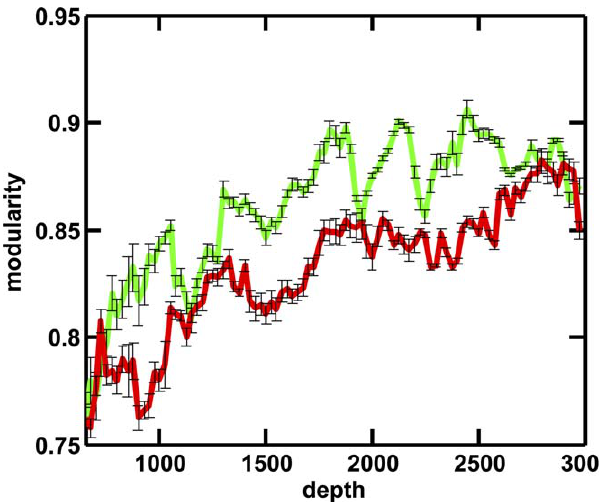
Figure 6. Network Modularity as a Function of Evolutionary Depth Network modularity score for networks evolving in a dynamic (red line) compared to a static environment (green line). Each line represents the average over nine independent runs. Errors are standard error. Because the modularity score can only be calculated for networks of sufficient size, we show the modularity starting at a depth of 650.